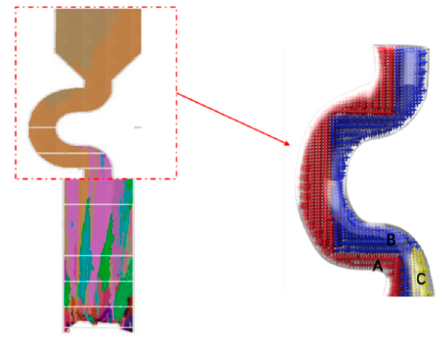
= 4 mm, d = 8 s 4 (d w